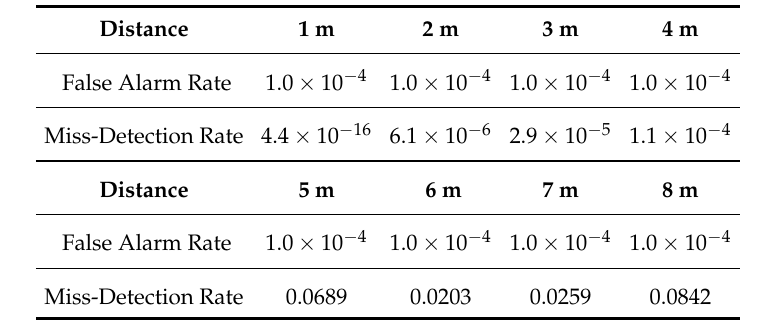
Table 5. Performance analysis in a light clutter environment when P Fa = 10 − 4 , P Md = 10 − 3 , α = 1 (CFAR algorithm).